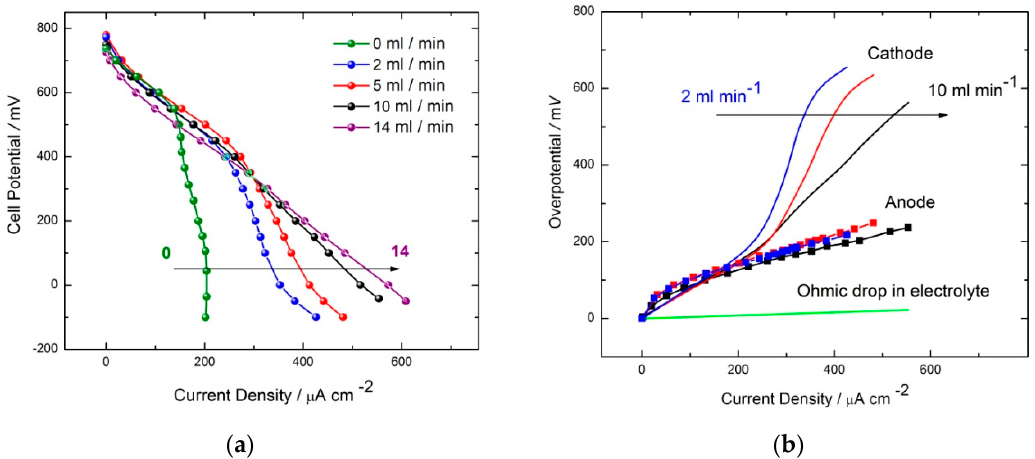
Figure 1. ( a ) Polarization curves of the electroenzymatic reactor at different flow rates; ( b ) Potential loss distribution, anode: GOx-TTF/Vulcan-Gelatin, cathode: GOx-HRP/Vulcan-PVDF, blue line- 2 mL min − 1 , red line 5ml min − 1 , black line 10 mL min − 1 , Conditions: 20 mM glucose in 0.1 M phosphate